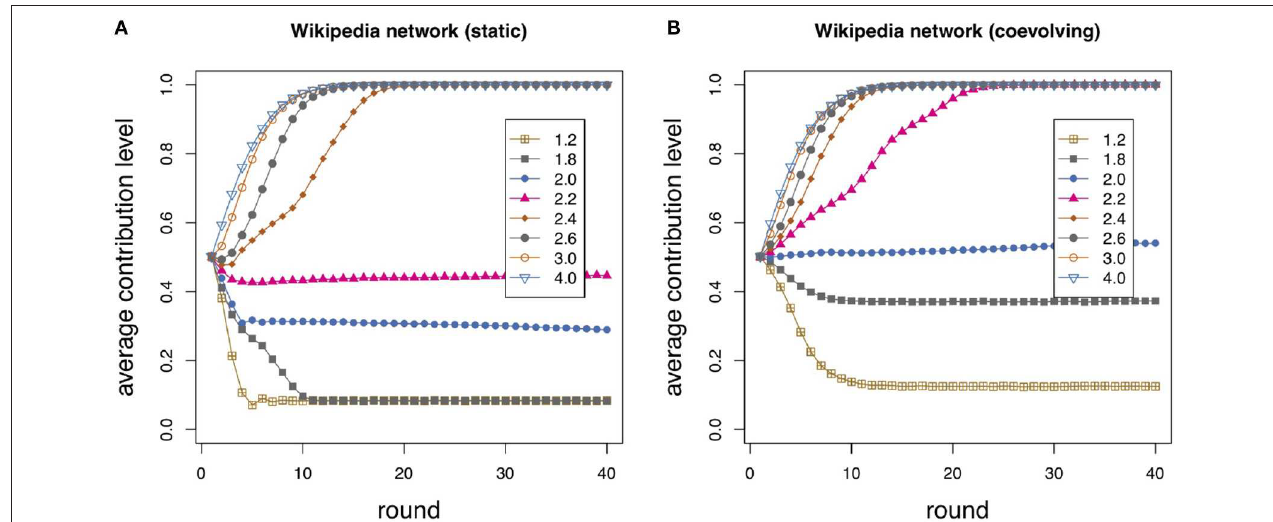
FIGURE 6 | Wikipedia “who votes on whom” network (see text for details). Average individual contribution as a function of round number for several values of the enhancement factor r as shown in the inset. The average is taken over 40 independent repetitions of 40 rounds on the Wikipedia network using (A) p = 0 (static case); (B) p = 0.5